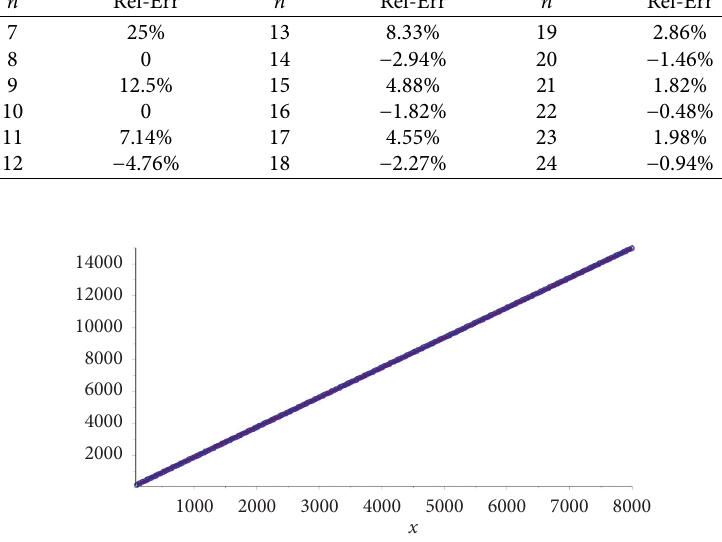
Figure 21: The graph of the data ( n, π exp ( π